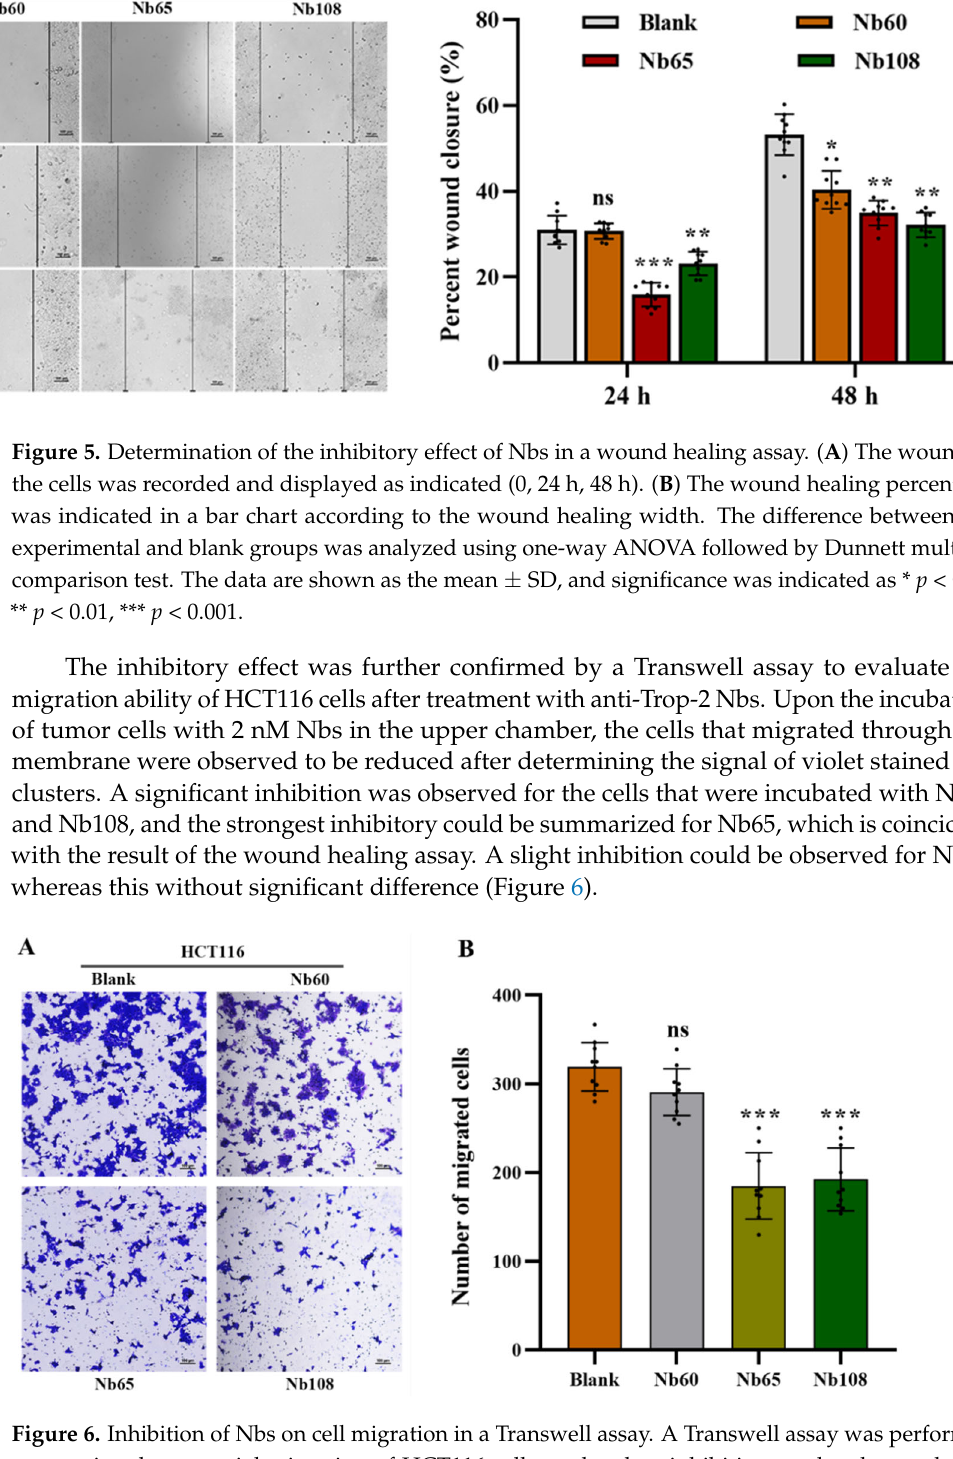
Figure 6. Inhibition of Nbs on cell migration in a Transwell assay. A Transwell assay was performed to examine the potential migration of HCT116 cells, and a clear inhibition can be observed after treating with selected Nbs ( A ). The inhibition of the selected Nbs on cell migration were indicated as a bar chart ( B ). The difference between the experimental and blank groups was analyzed using one-way ANOVA followed by Dunnett multiple comparison test. The data are shown as the mean ± SD, and significance was indicated as *** p < 0.001.